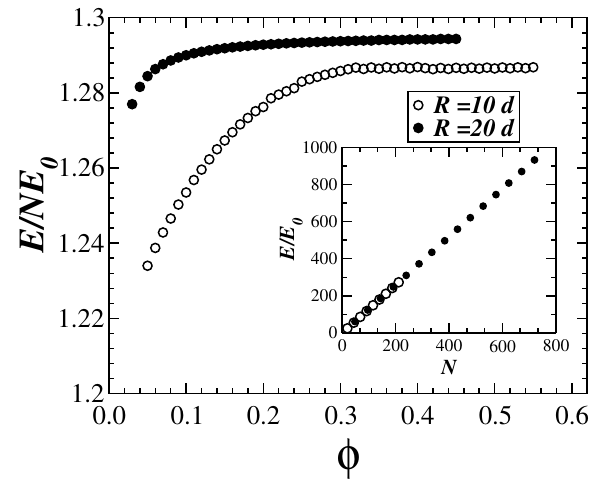
Figure 6. Total magnetic energy E normalized by E 0 (the mini- mum energy of a pair of dipoles of moment mmm at distance equal to the particle’s radius) as a function of packing fraction ob- tained from the simulation. The simulation was performed for the flower-like pattern for two di ff erent cavity sizes, R = 10 d (open symbols) and R = 20 d (full symbols). The inset shows the energy density versus the packing